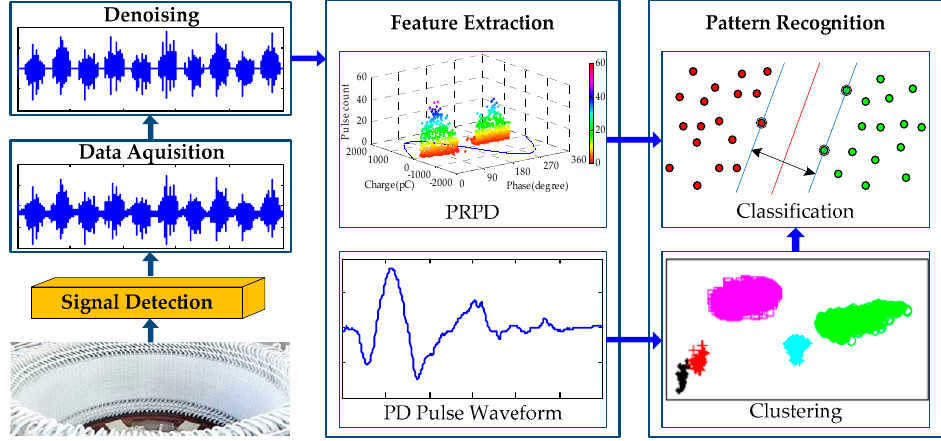
Figure 2. Flowchart of PD online measurement in large generators [9,10].